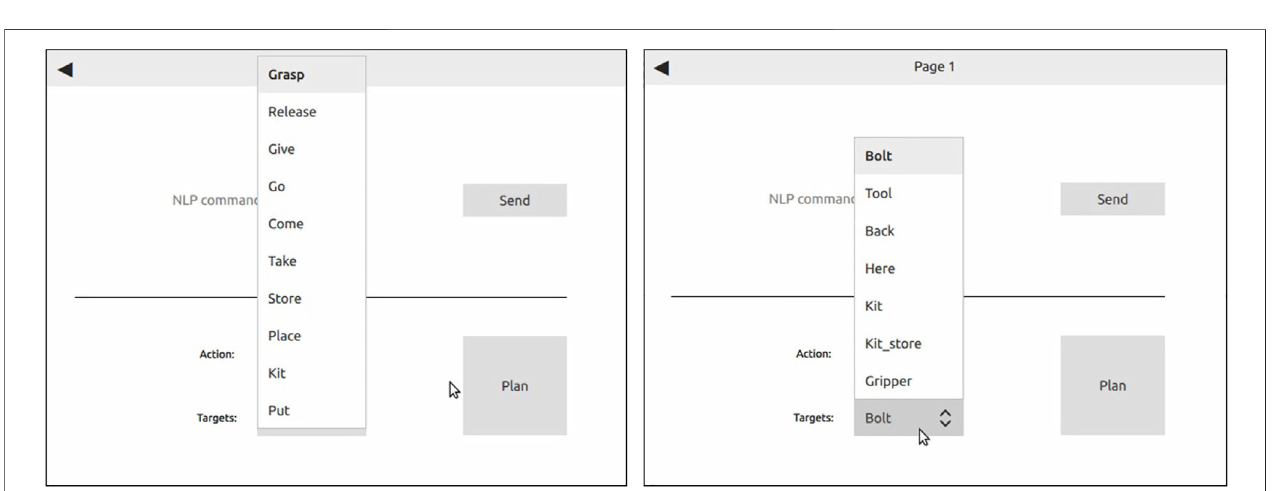
FIGURE 2 | The graphical command interface enables actions and targets to be selected from a drop-down menu. Left: available actions. Right: available